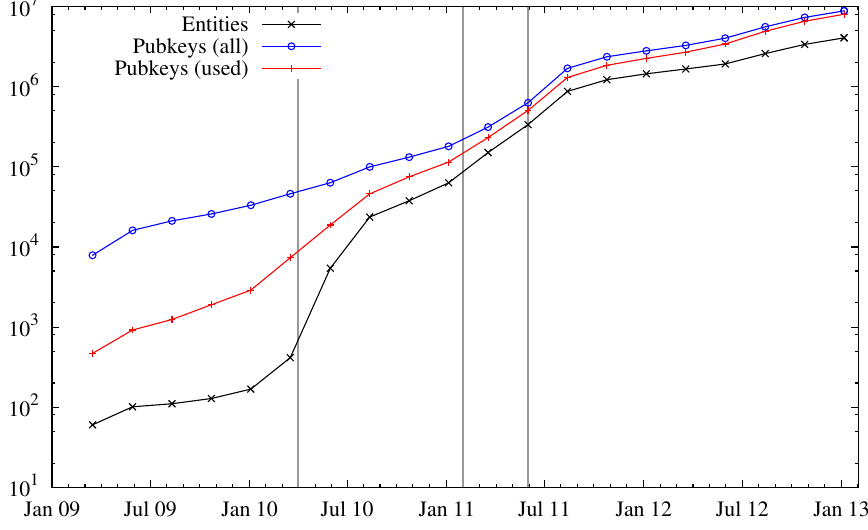
Figure 1. Number of all public keys, used public keys and entities. The three vertical gray bars indicate three important events in the history of Bitcoin: start of public trading (leftmost), a post on Slashdot (middle) and an article on Gawker